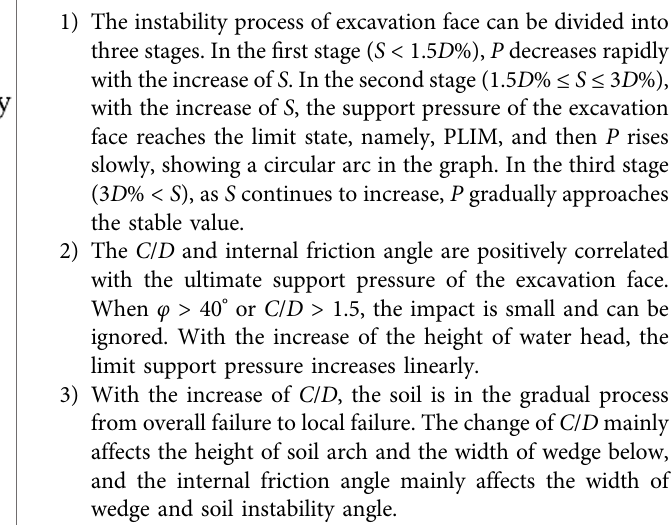
FIGURE 12 | Relationship between cohesion and instability mode of